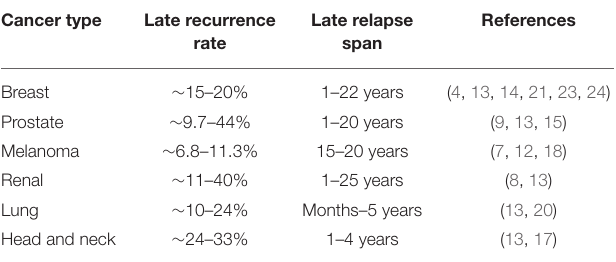
TABLE 1 | Metastatic relapse rate and latency span in cancer patients. Cancer